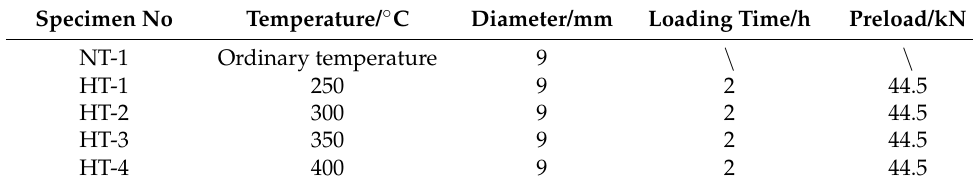
Figure 3. Tensile test process of CFRP tendon at high temperature. ( a ) Test process ( b ) control box ( c ) Heating curve of heating furnace. Table 1. Test conditions of tensile test